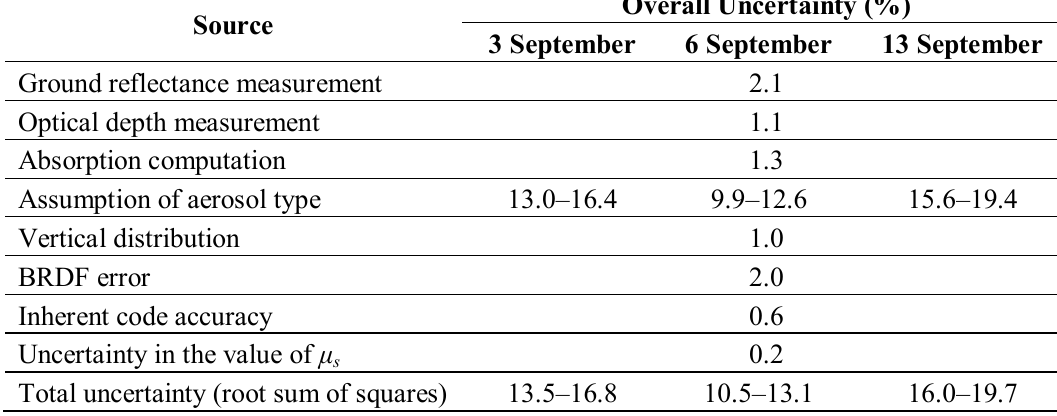
Table 8. Estimated uncertainty in the irradiance-based method.